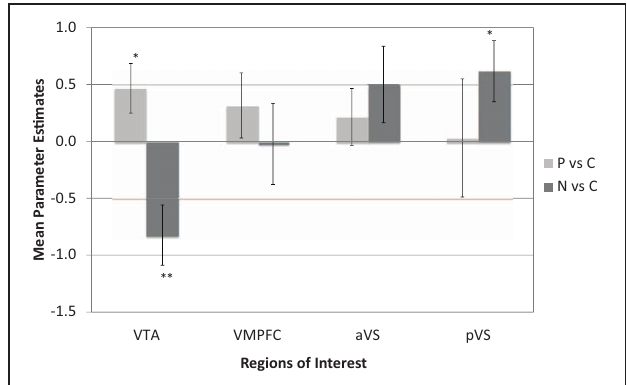
FIGURE 3 | Mean differences in ROI parameters, by contrast. ∗ = p < 0 . 05, ∗∗ = p < 0 . 01. Note: P vs C = Positive Violations – Confirmations; N vs C = Negative Violations –